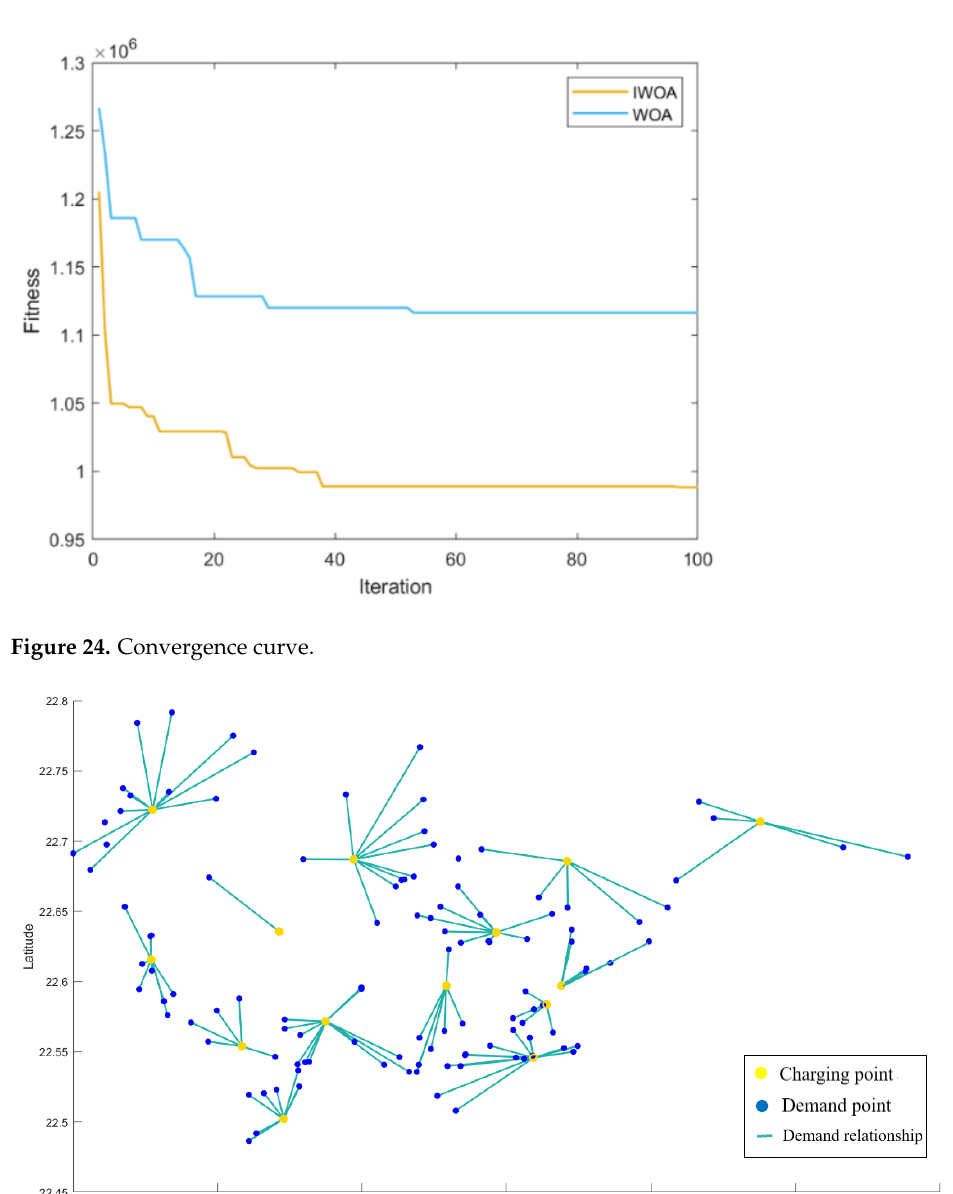
Figure 25. Optimization results of charging station site selection.